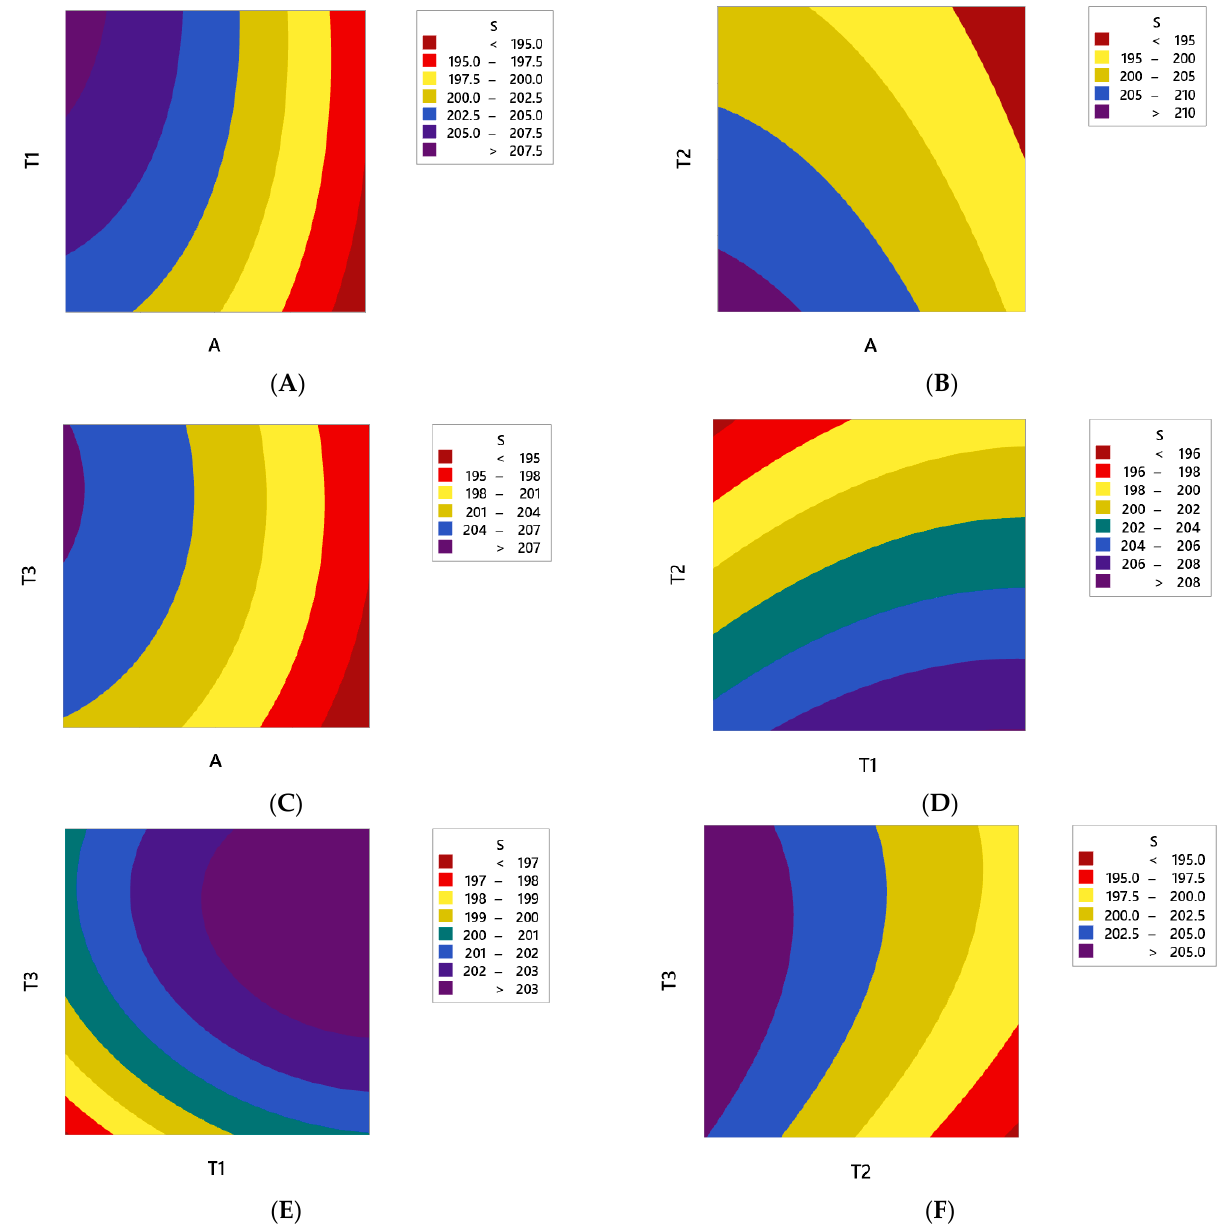
Figure 9. RSM results for maximum principal stress in a variable wall-thickness composite CNG tank including ( A ) vari-